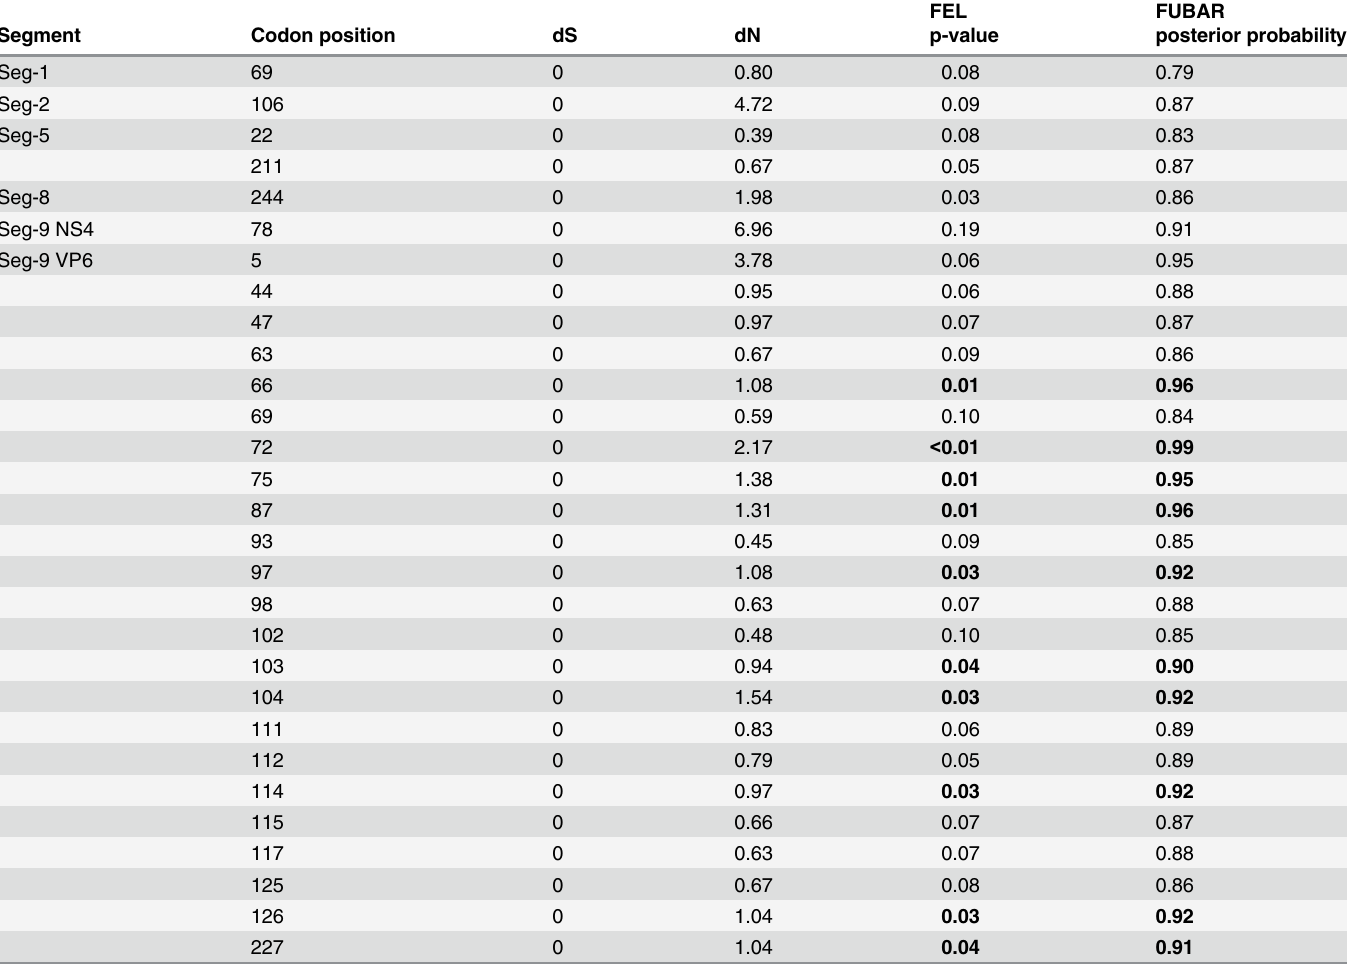
Table 3. Sites potentially under positive selection in the BTV genome according to two inference methods (FEL — fixed-effects likelihood [47], FUBAR — Fast Unconstrained Bayesian Approximation [48]). Sites with statistically strong evidence (p-value < 0.05 and posterior probability > 0.90) are shown in